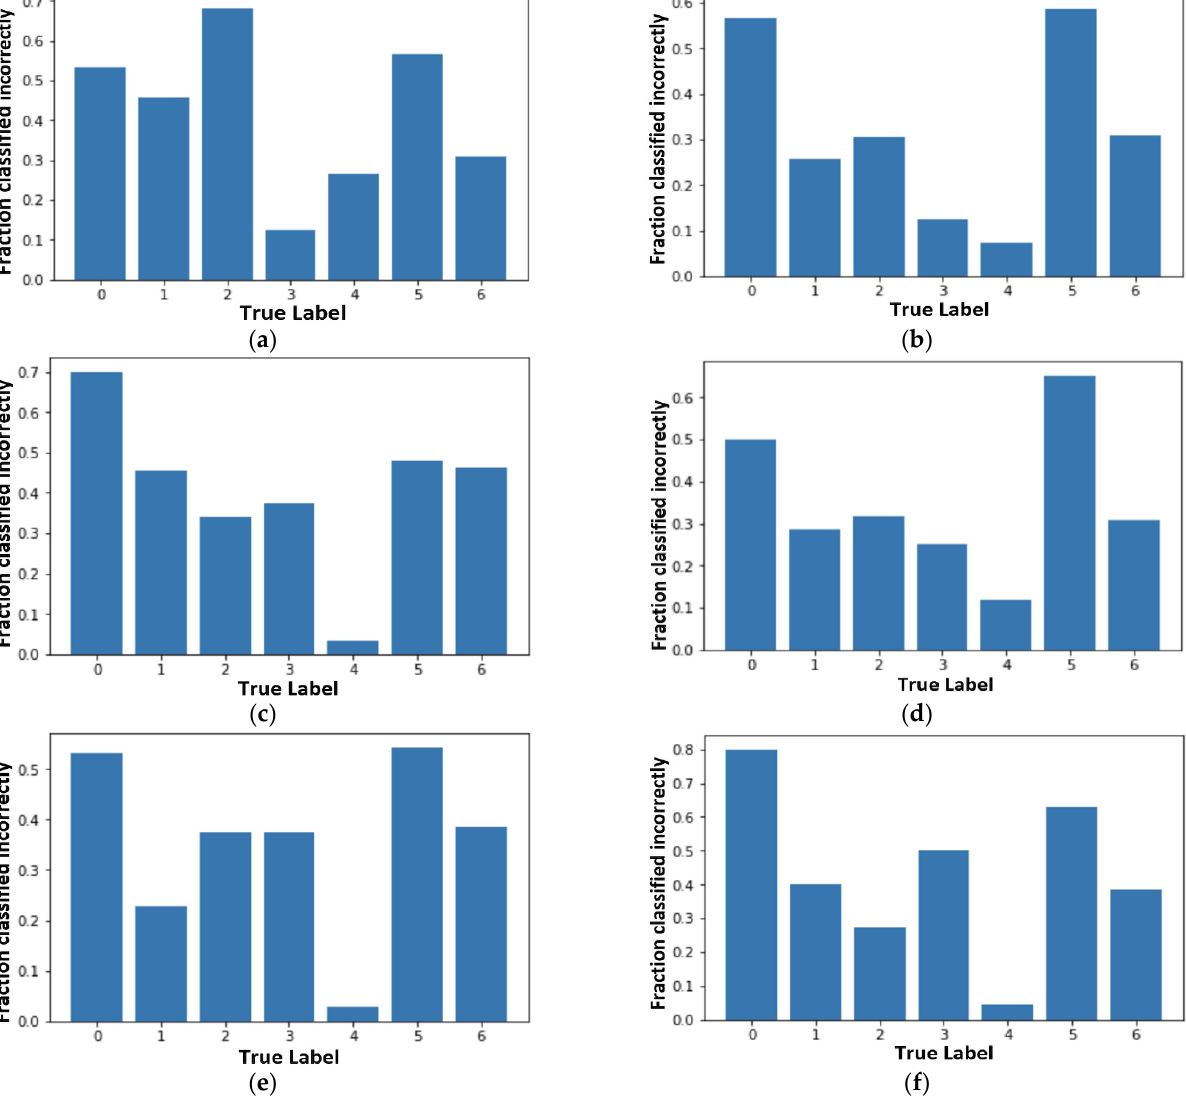
Figure 5. Fraction classified incorrectly for all seven models: ( a ) VGG19; ( b ) InceptionV3; ( c ) InceptionResNetV2; ( d ) ResNet50; ( e ) Xception; ( f ) MobileNet.